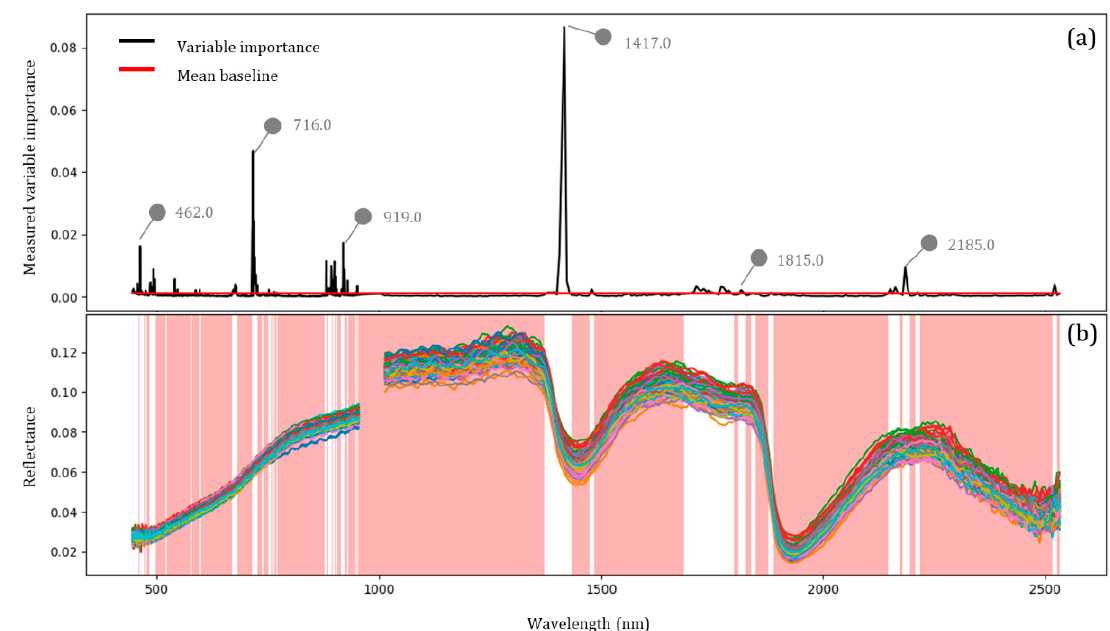
Figure 3. Variable importance values extracted by the Random Forest (RF) regression model ( a ) and removed variables based on the mean baseline (red region) ( b ).